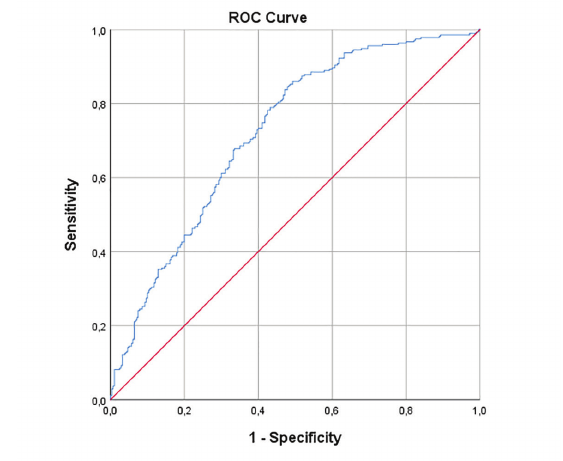
Figure 1 - ROC curve for estimate mortality in